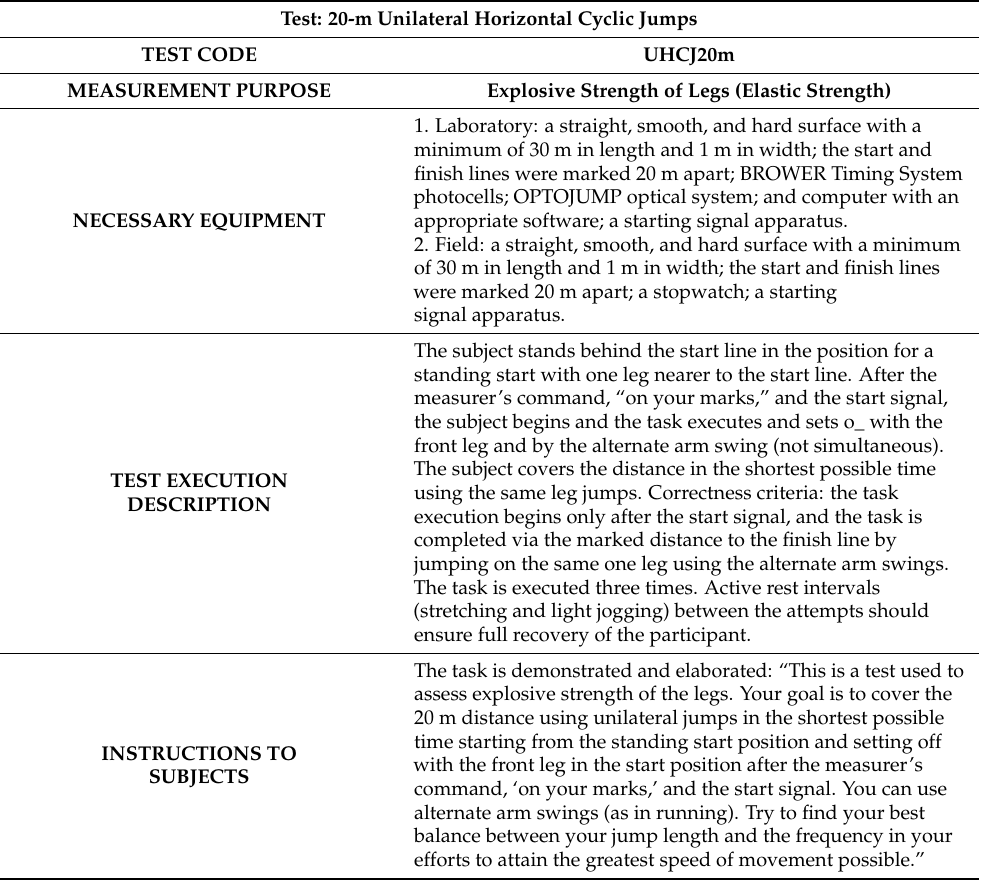
Table A1. Representation of the standardization of the UHCJ20m test